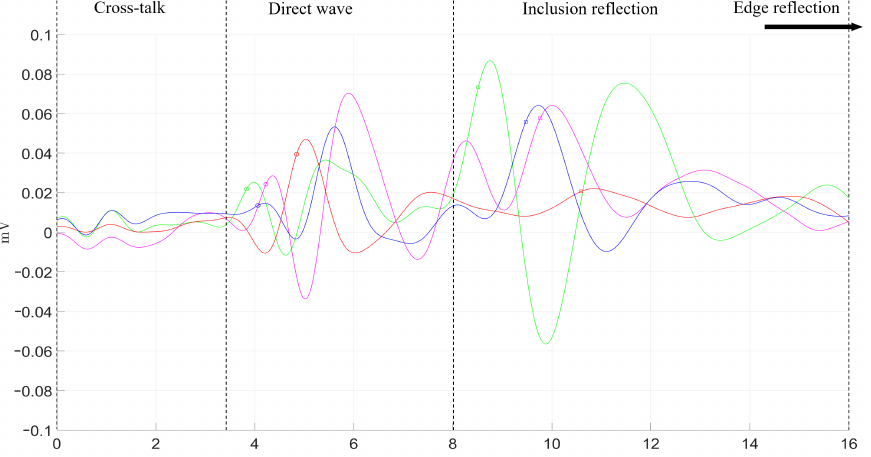
Figure 6. Readout from the four sensors (color code in Figure 3) and expected time-of-flight of the different paths of wave propagation in Phantom A. The vertical dashed lines represent the estimated time-of-flight calculated from the shear-wave velocity. The reflected wave against the outer surface of the phantom was not recorded due to a technical compromise between time resolution and the limited memory acquisition of the equipment